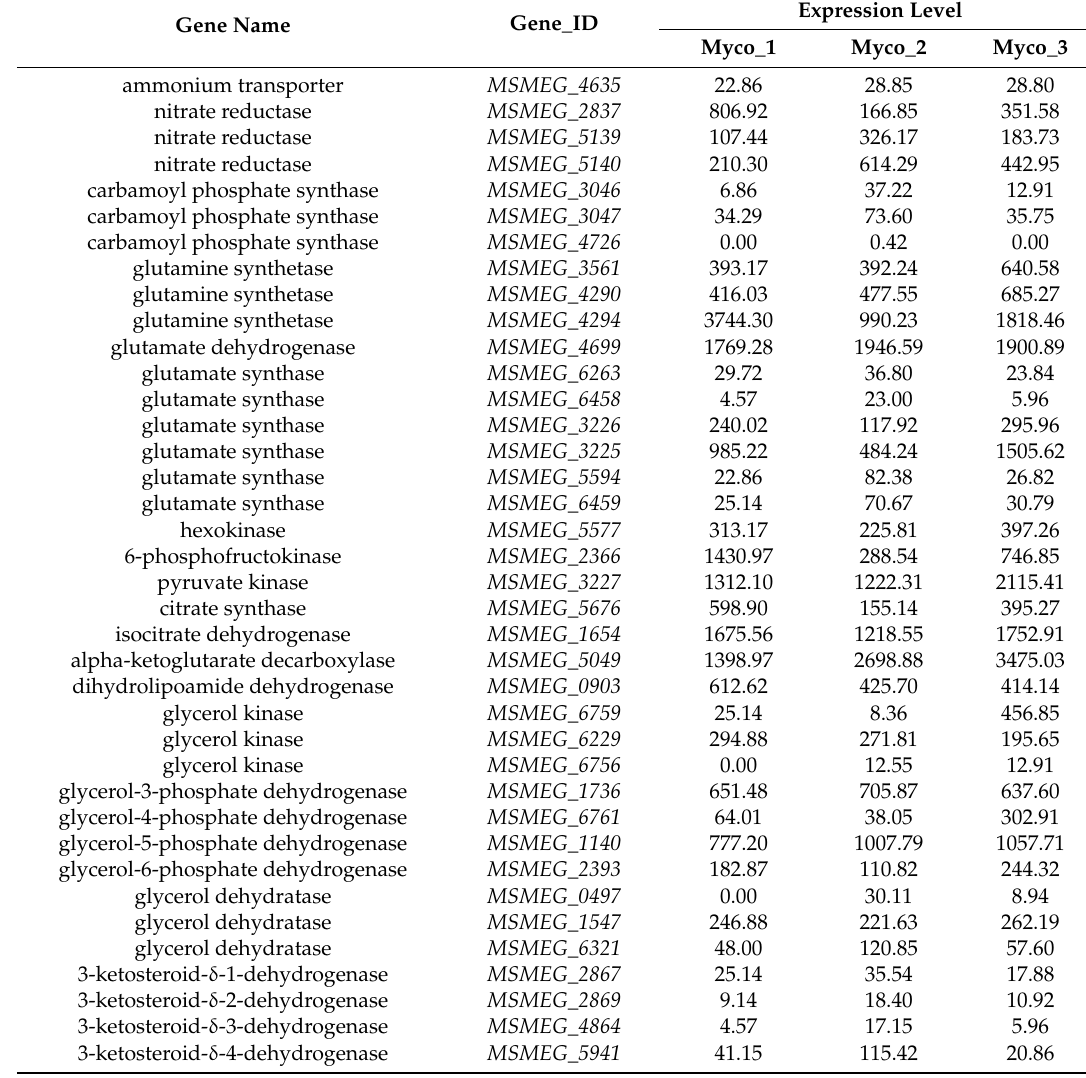
Table 2. Expression level of nitrogen and carbon metabolism, and also glycerol and androstenedione metabolism related